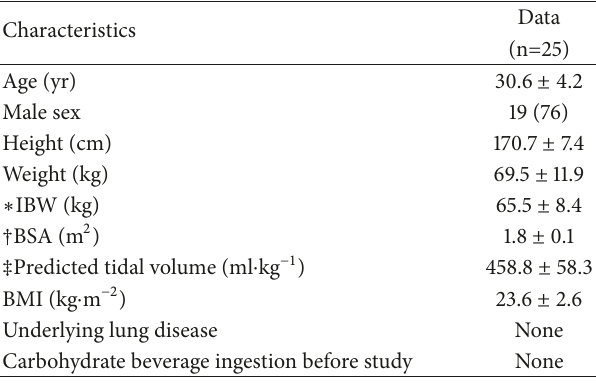
Table 1: General